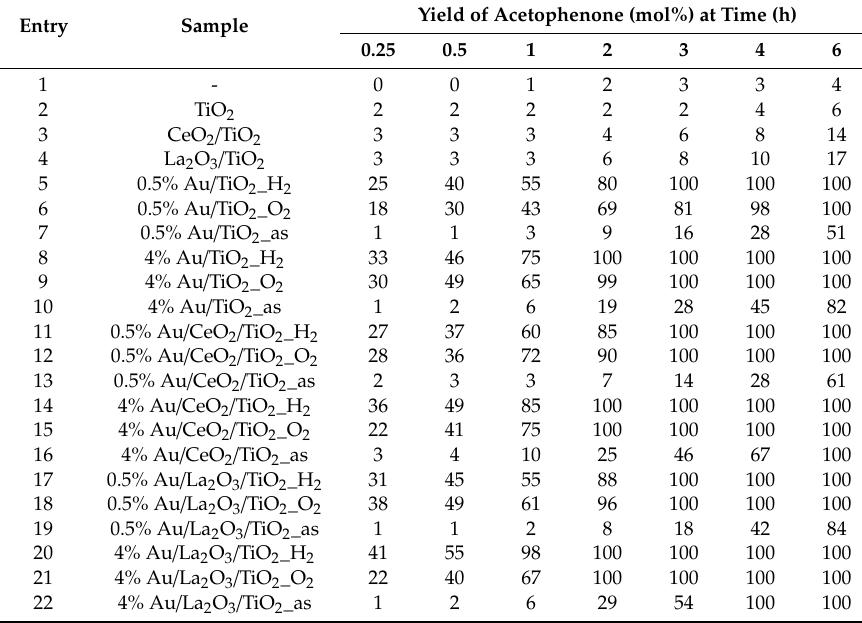
Table 2. Catalytic results of peroxidative oxidation of 1-phenylethanol 1 .